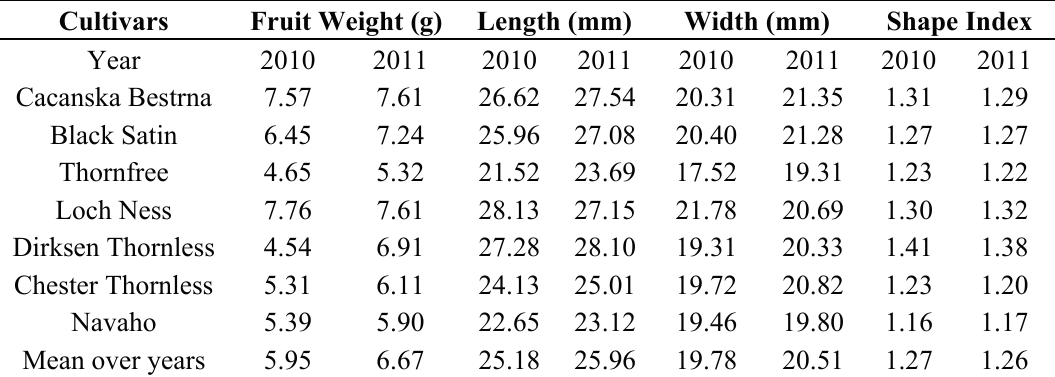
Table 1. Fruit weight, berry size and berry shape index of blackberry fruits grown in Serbia [22].